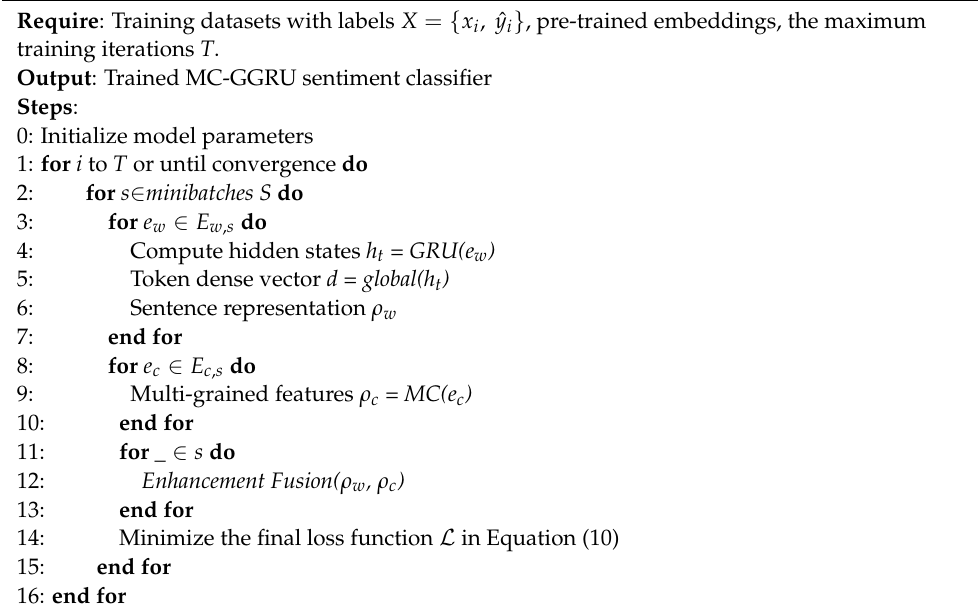
Algorithm 1. Hybrid multi-grained embedding-based lightweight model